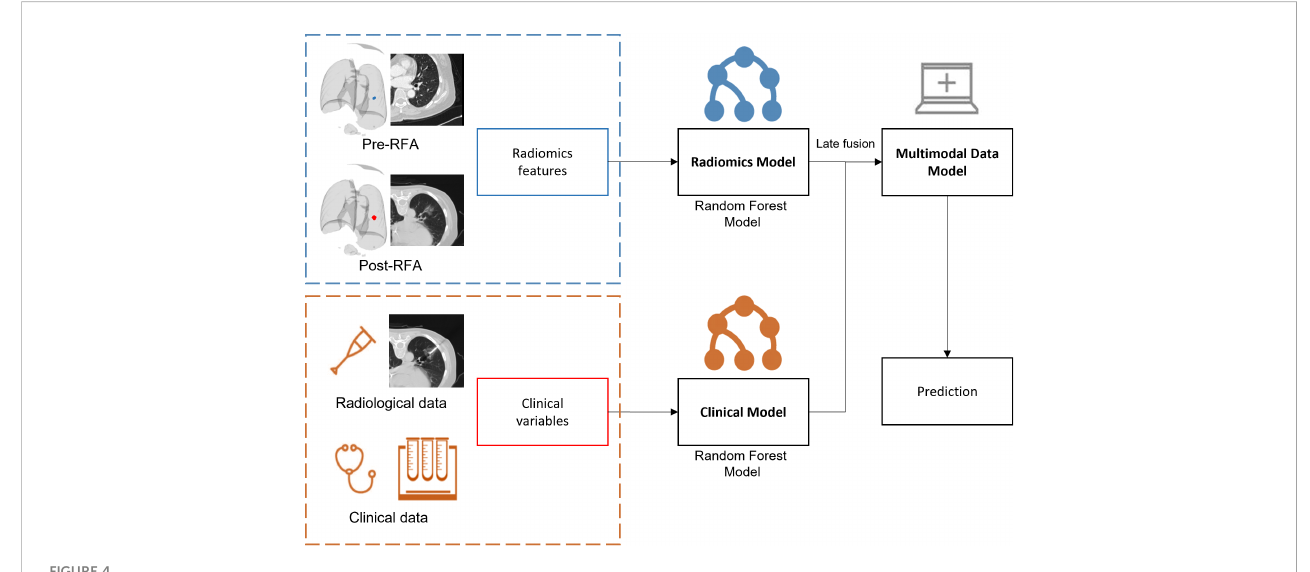
FIGURE 4 Fusion framework of radiomics features and clinical